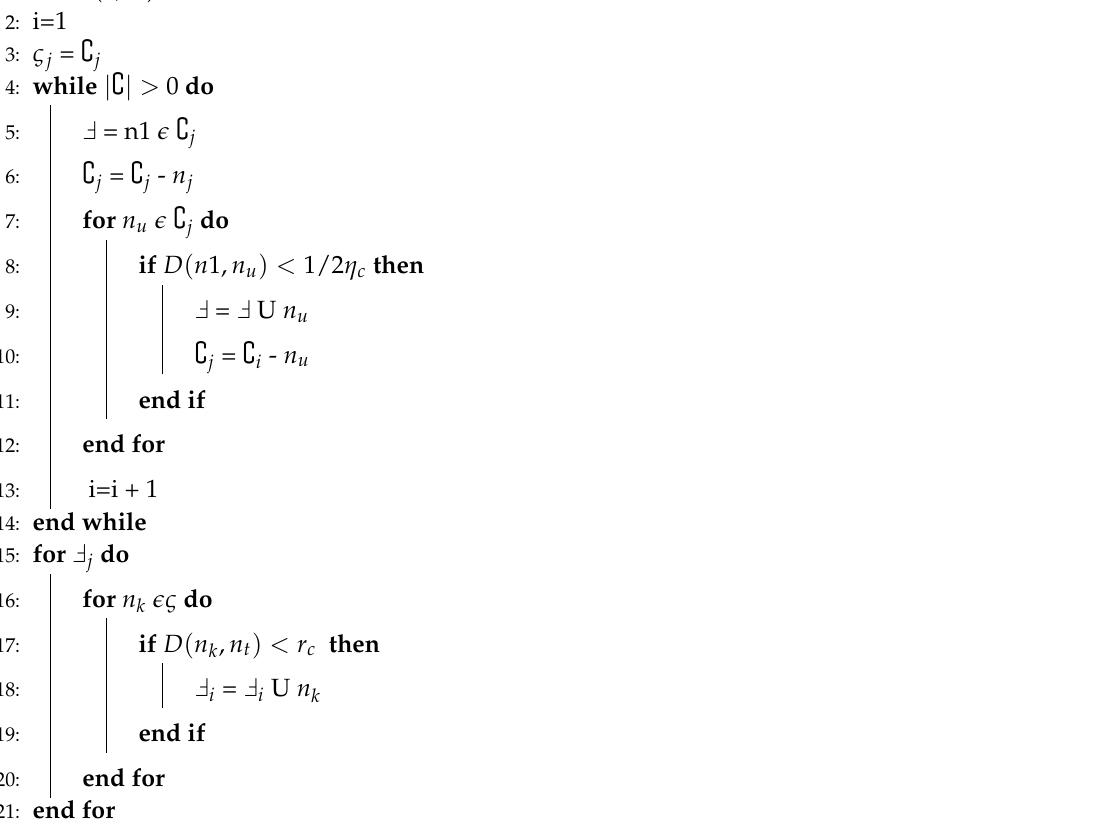
Algorithm 3 Next forwarder node selection